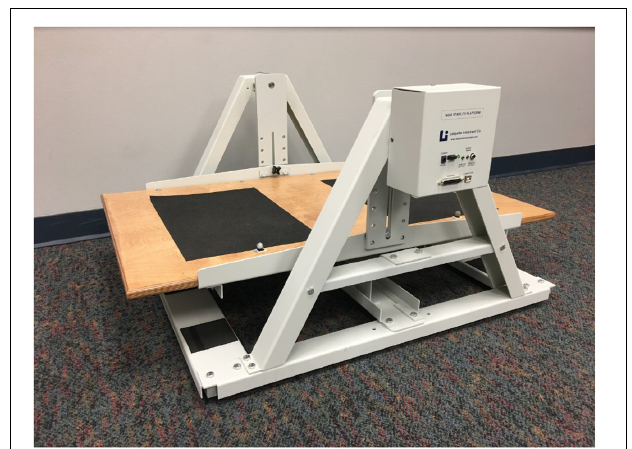
FIGURE 1 | Stability